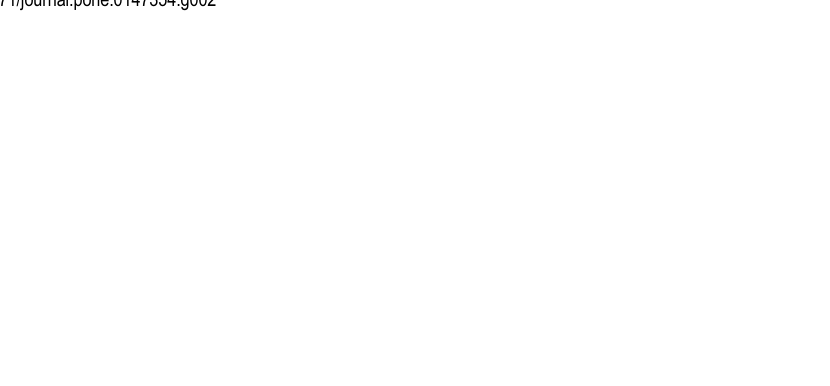
Fig 4. Conditions tested in three or more trials (continuous outcomes)